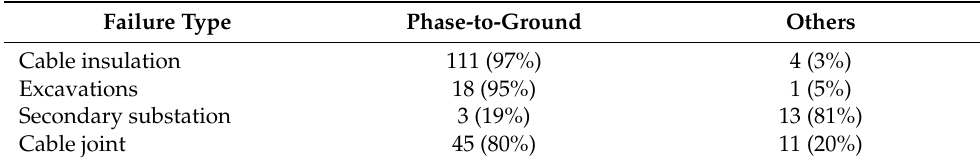
Table 1. Fault type of the observed